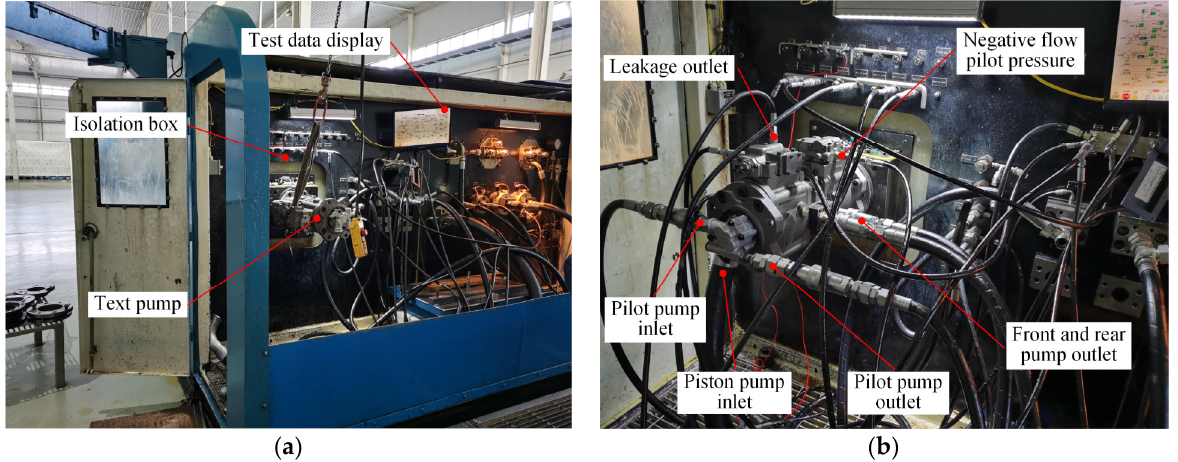
Figure 11. Performance test system for the double-compound axial piston pump: ( a ) test rig; ( b ) tested pump. Table 3. Technical characteristics of measuring